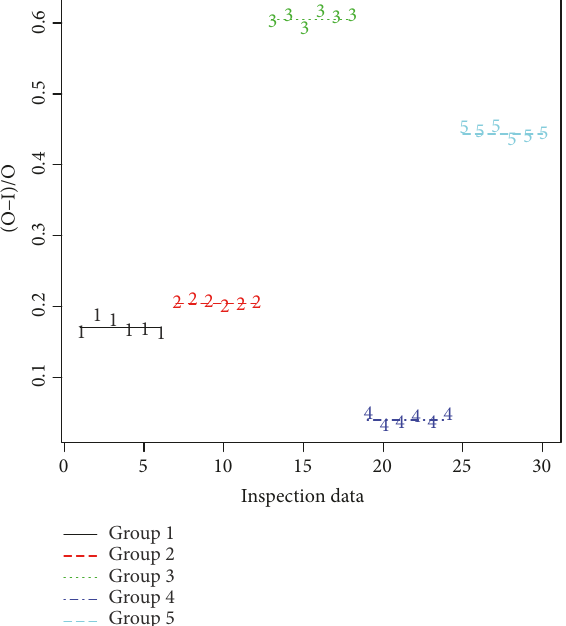
Figure 4: A plot of results of two change detection option s (moving average difference = “2” and Page’s cumulative sum = “3” for positive shift detection and “4” for negative shift detection).